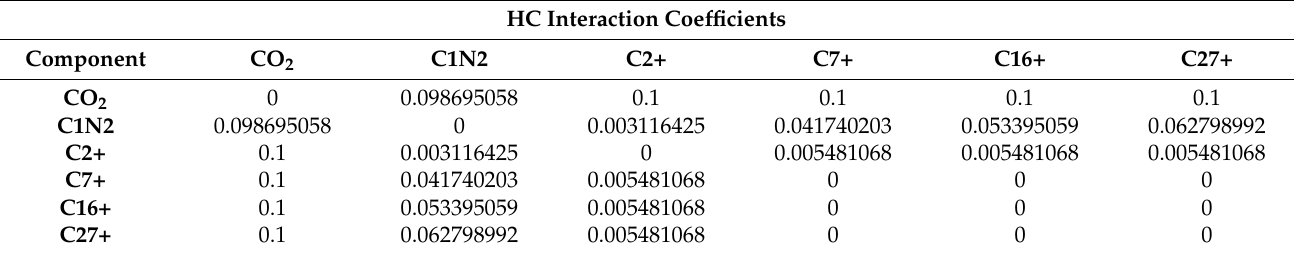
Table 3. Interaction coefficient of each component.